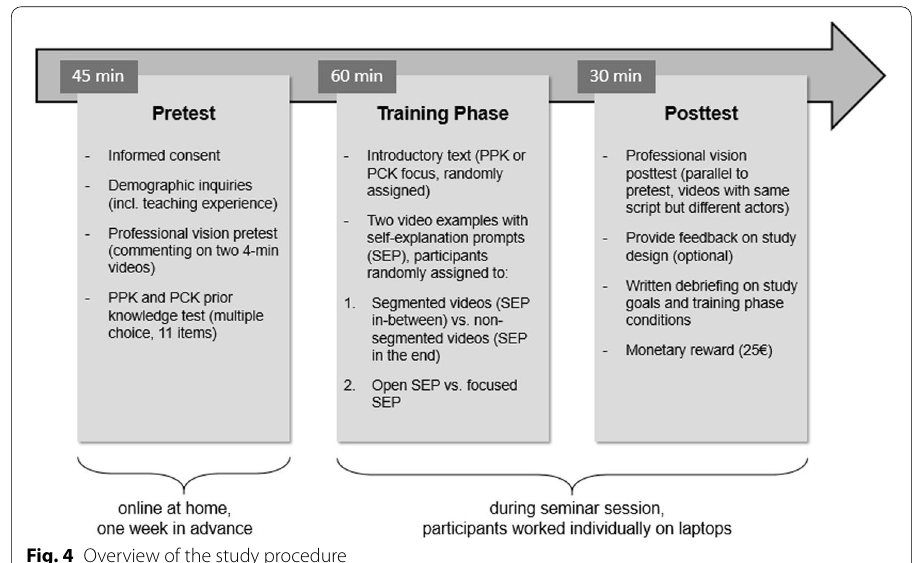
Fig. 4 Overview of the study